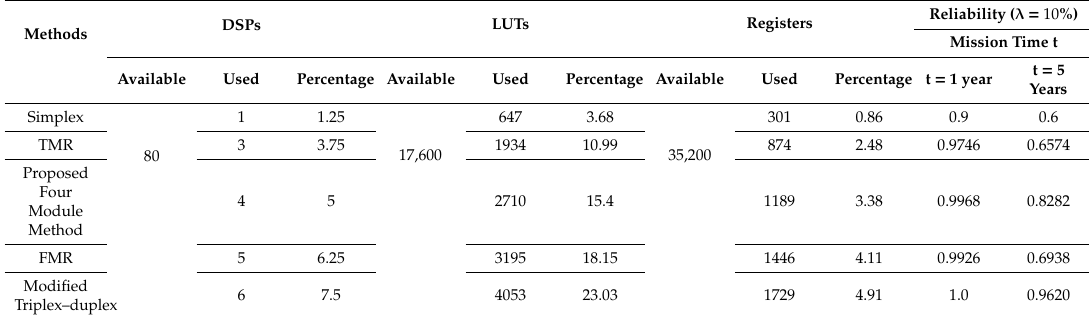
Table 2. FPGA resource utilization summary and reliability